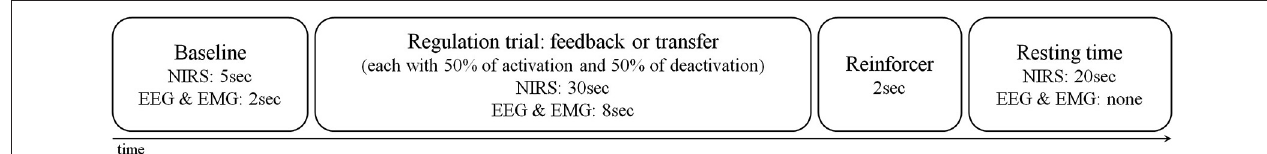
FIGURE 1 | Trial design of NIRS-, EEG- and EMG- blocks . One NIRS session consisted of 2 feedback blocks each with 12 trials and 1 transfer block with 8 trials. An EEG and EMG session consisted of 3 feedback blocks and 1 transfer block each with 40